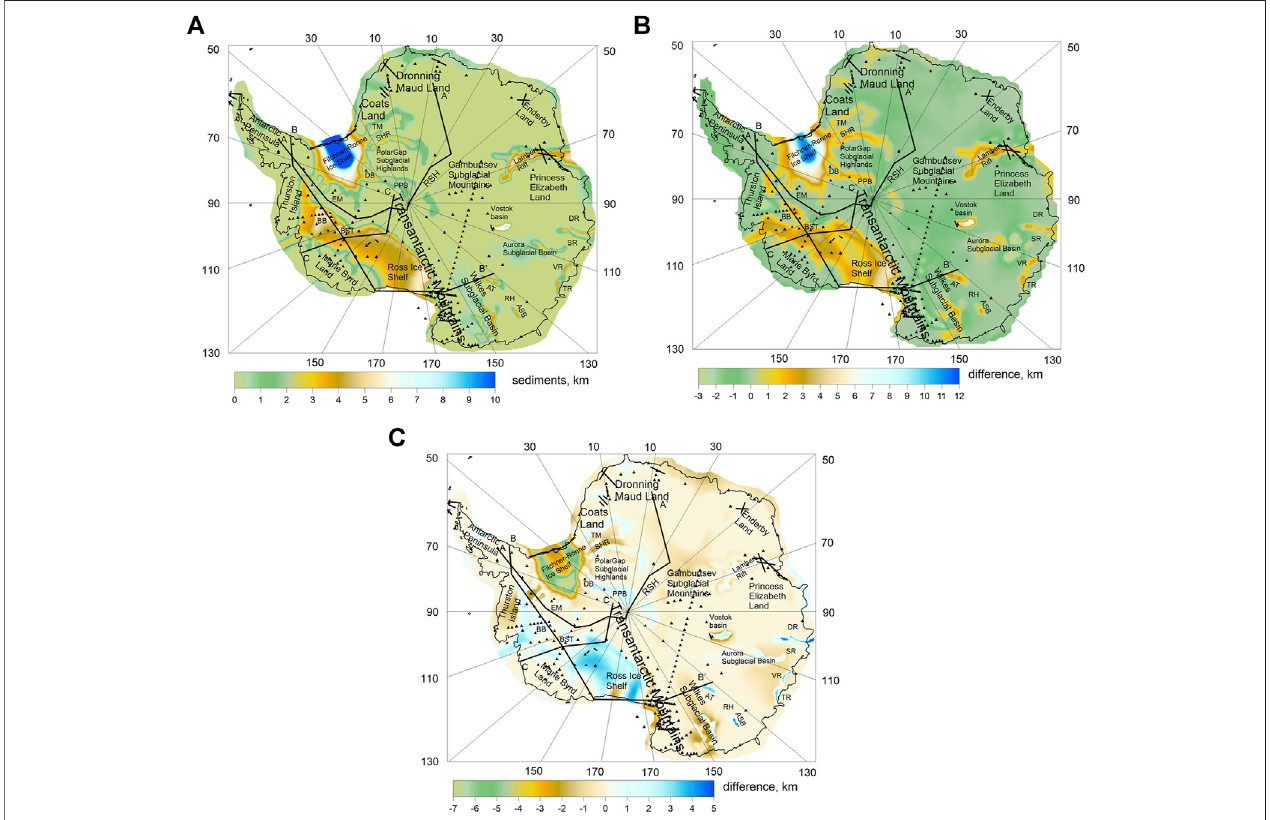
FIGURE 3 | (A) Map of a sediment thickness for Antarctica (ANTASed). It is used the same abbreviations as in Figure 1 . (B) Difference between ANTASed model and the CRUST 1.0 model. (C) Difference between ANTASed and preliminary sediment model from Baranov et al. (2018a).